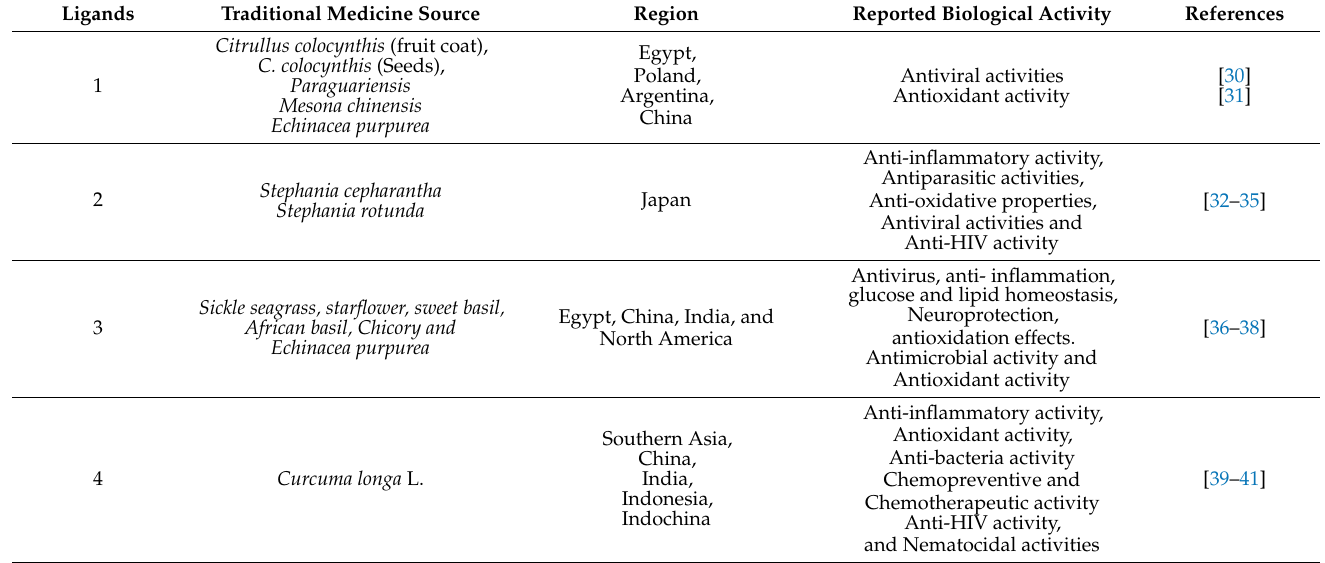
Table 1. Traditional medicinal source for bioactive compounds docking ligands toward